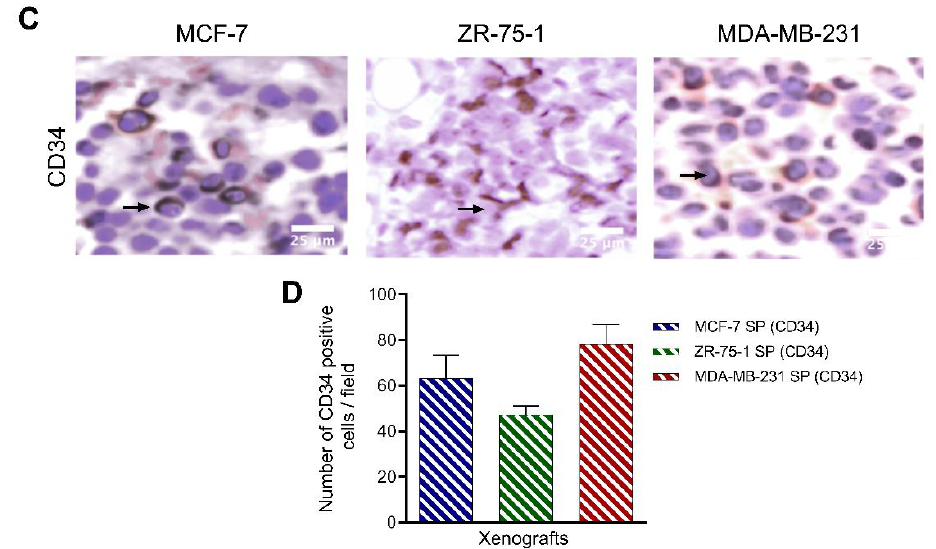
Figure 12. 3D stem-like derived spheroid breast tumor xenografts express vascularization markers. Light microscope images of H&E-stained tumor tissue segments from xenografts generated from MCF-7, ZR-75-1, and MDA-MB-231 spheroids were stained using primary antibodies against ( A , B ) CD31 (1:50) or ( C , D ) CD34 (1:2500) to determine the degree of vascularization. Graphs show the number of positive vascularization marker immunostained cells per field ± SEM; three independent experiments performed in triplicates.